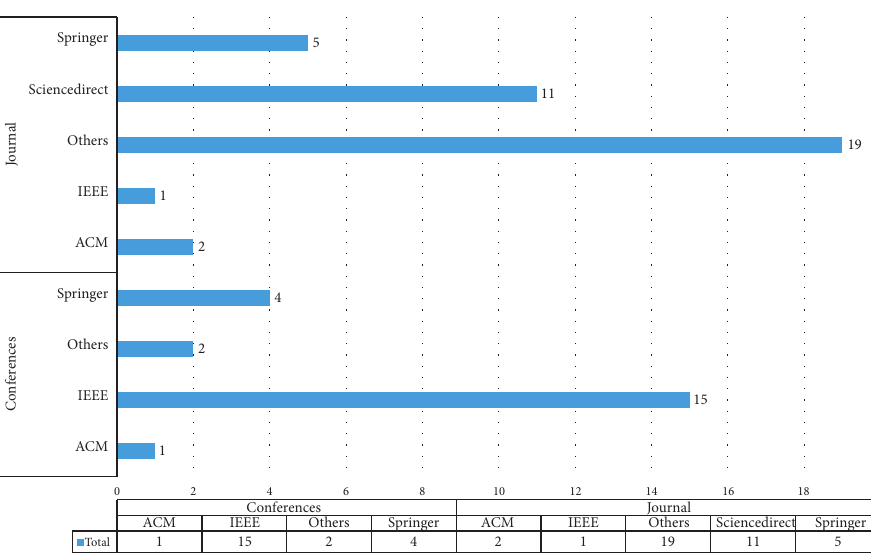
Figure 8: Statistics of publishers by type of published